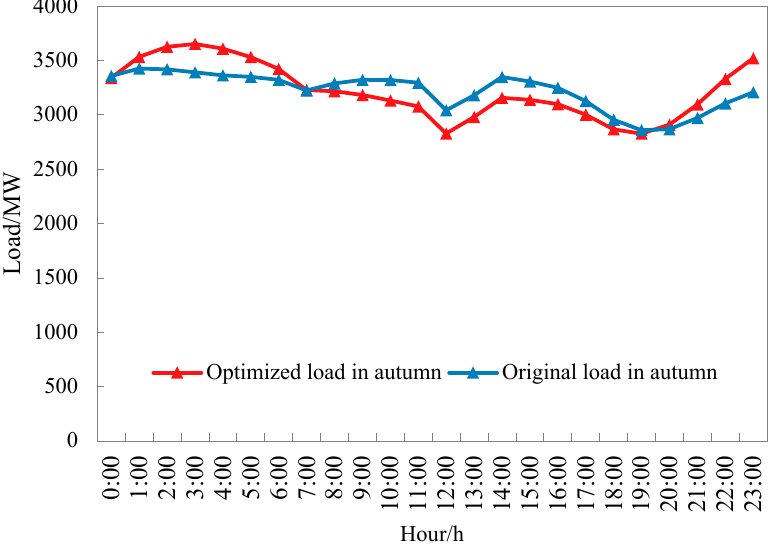
Figure 5. The load optimization results in autumn. Compared with the original tariff, the tariff in the peak period increased by 8.57%, and the tariff in the valley period decreased by 23.30%. Due to the adjustment of electricity prices, users spontaneously change their electricity consumption behavior. As shown in Figure 5, the maximum load growth during the valley period reached 9.75% (23:00 p.m.), and the maximum load reduction during the peak hours reached 5.73% (10:00 a.m.). Through the TOU tariff optimization, the gap between the maximum and minimum load of industrial users expanded from 566.69 MW to 825.49 MW. (4) Optimization results for TOU tariff in winter. First, the price elasticity coefficient of industrial users’ electricity demand in winter was calculated, as shown in Table A4. Then, the TOU tariff and load optimization results in winter were calculated, as shown in Table 7 and Figure 6. Table 7. The TOU tariff optimization results in winter.